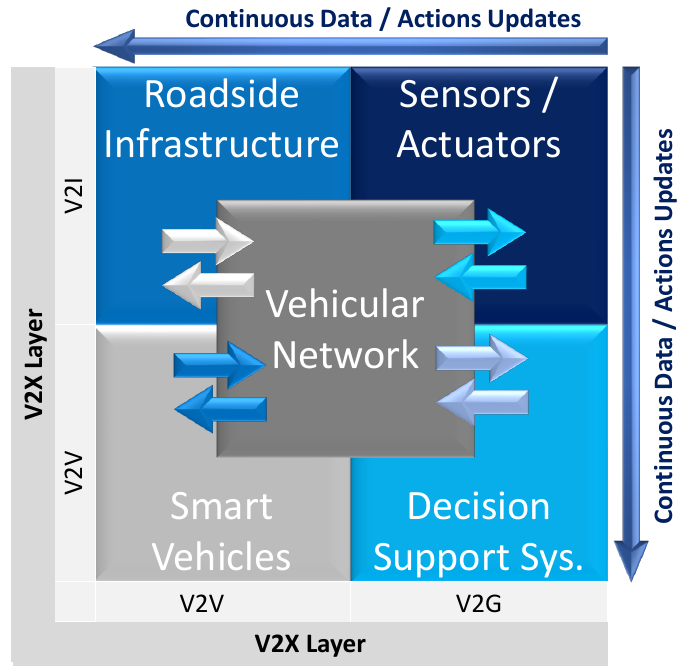
Figure 2. Smart transport